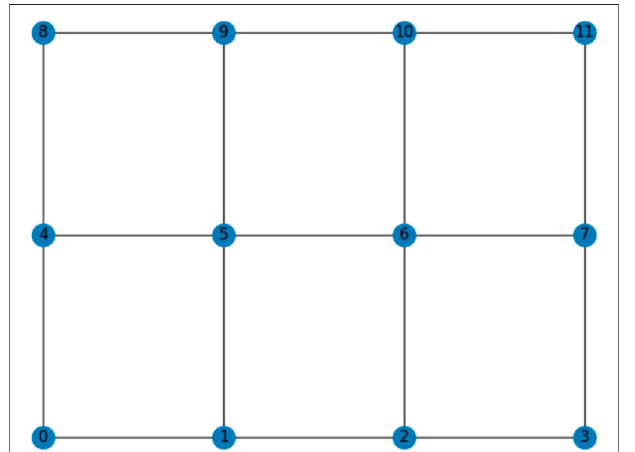
FIGURE 4 | Node numberings for 3 × 4 lattice.